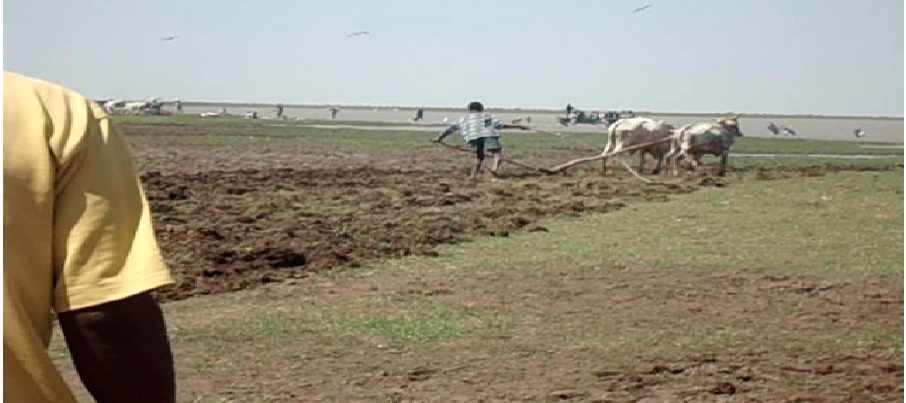
Figure 8. Recession farming near Lake Tana and wetlands. Table 7. Availability of recession farming practices.